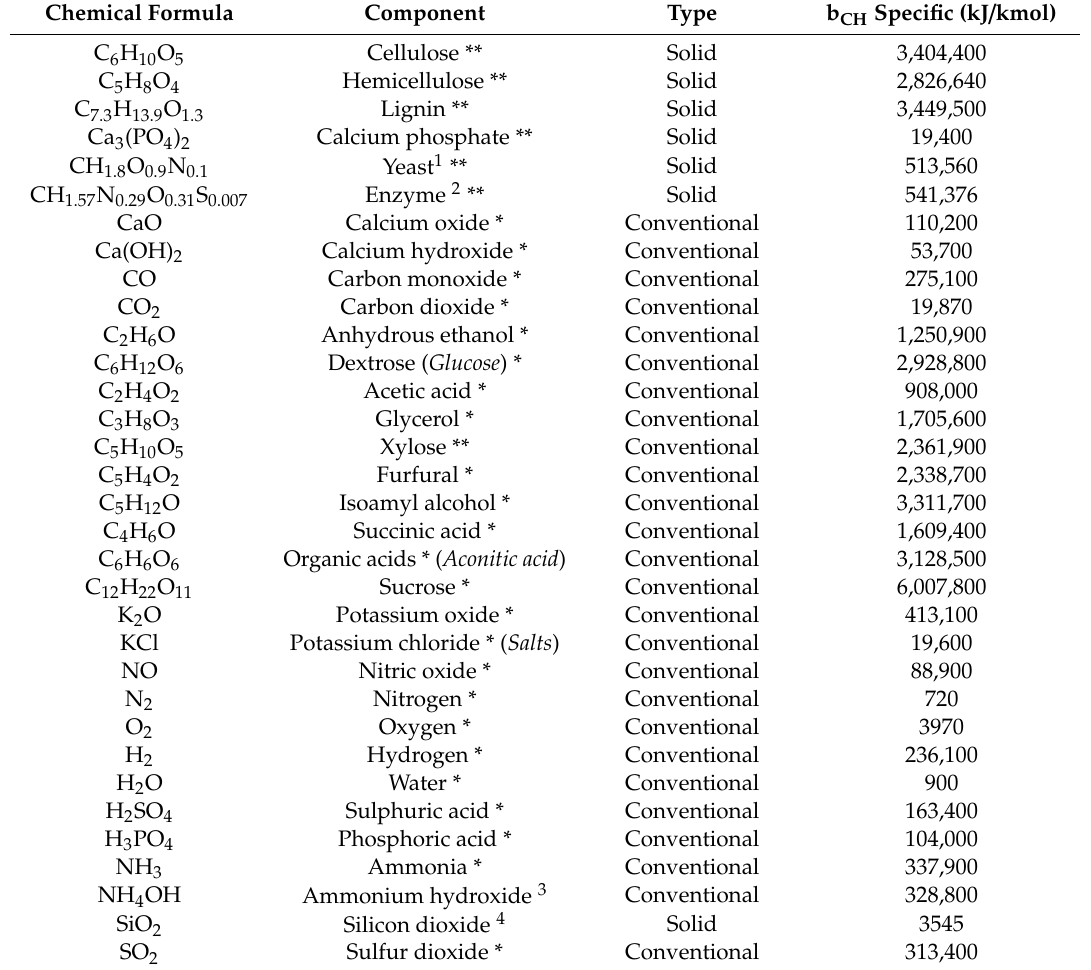
Table A12. Standard chemical exergy of the compounds used in the